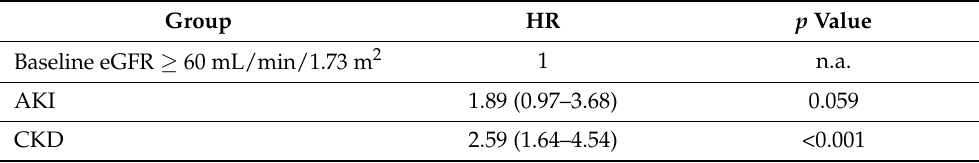
Table 4. Risk for developing the composite outcome according to AKI and CKD, considering